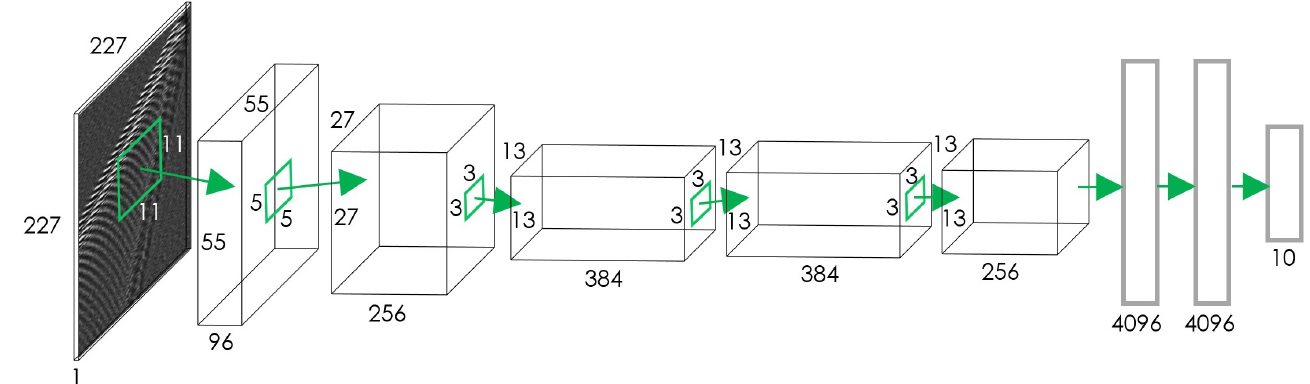
Figure 3. The architecture of AlexNet is used for training from scratch. The input SAR image has a size of 227 × 227 × 1 and a fully connected output layer for 10